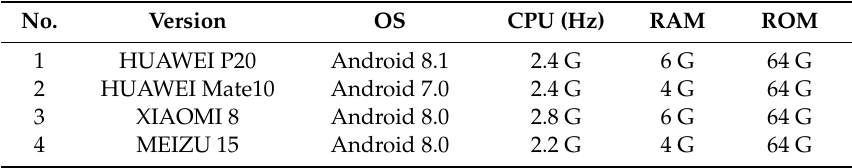
Table 5. Configuration list of di ff erent mobile phones.